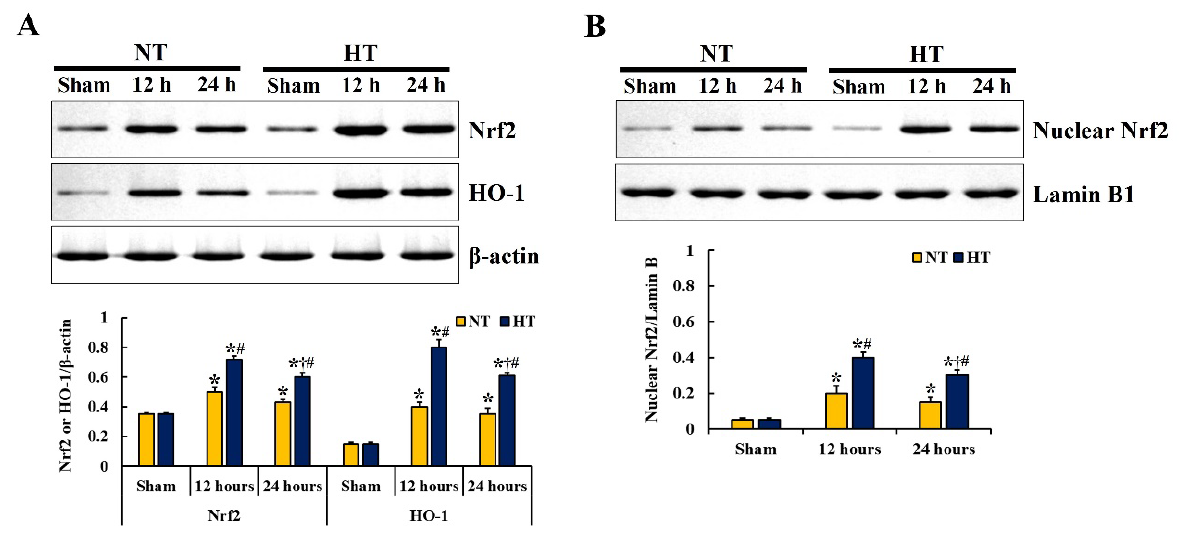
Figure 4. Representative western blot images and relative protein expression levels of Nrf2 and HO-1 ( A ), and nuclear Nrf2 ( B ) in the lumbar spinal cord of the sham-NT, sham-HT, CA-NT, and CA-HT groups at 12 and 24 h after CA/ROSC. In the CA-HT group, the levels of Nrf2, HO-1, and nuclear Nrf2 proteins are significantly increased at 12 and 24 h after CA/ROSC compared with the CA-NT group. The bars indicate the means ± SD ( n = 5, respectively; * p <0.05 vs. each sham group; † p < 0.05 vs. previous time-point group; # p < 0.05 vs. corresponding CA-NT group).